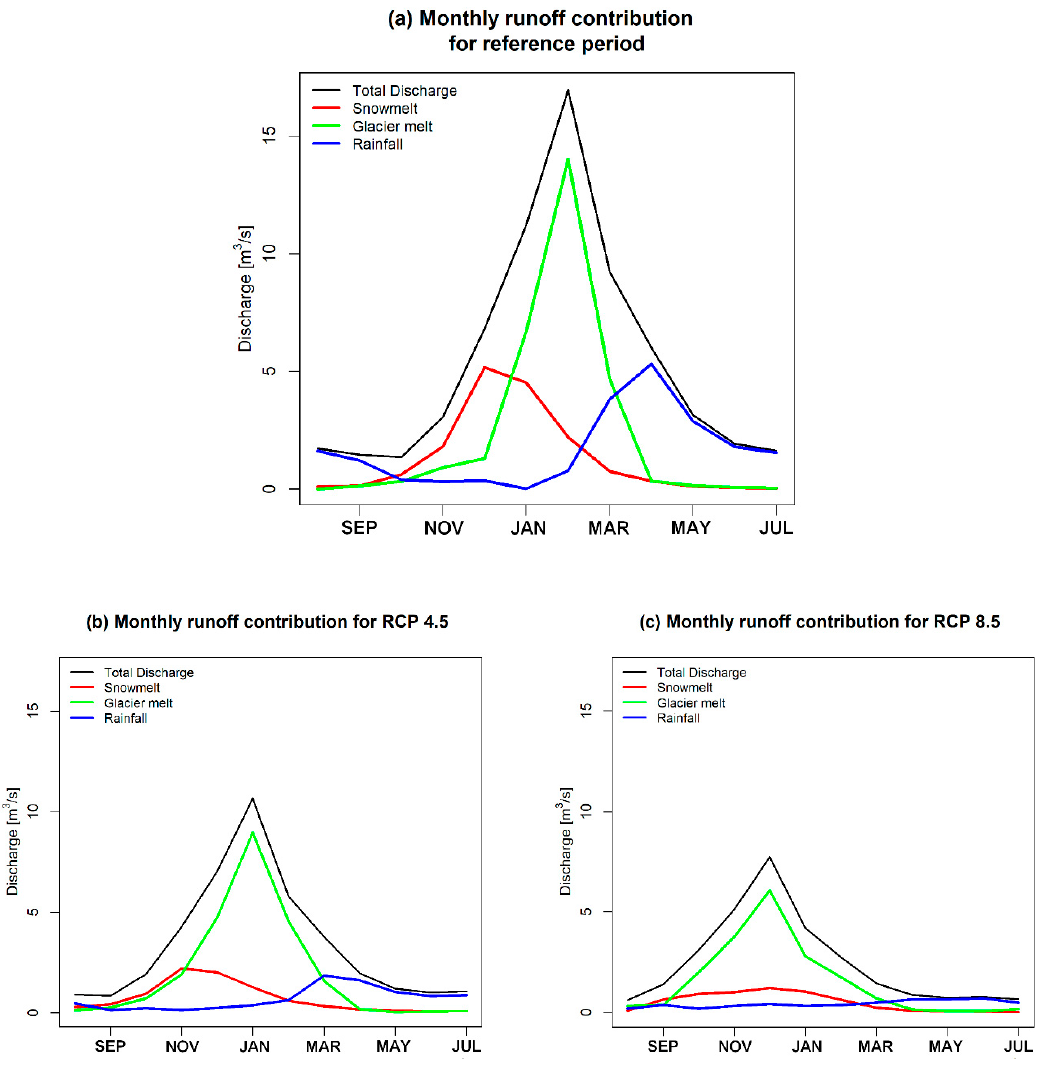
Figure 8. Monthly runoff contributions: ( a ) For the reference period (2008–2014); ( b ) For 2100 under emission scenario RCP 4.5 and ( c ) For 2100 under emission scenario RCP 8.5.